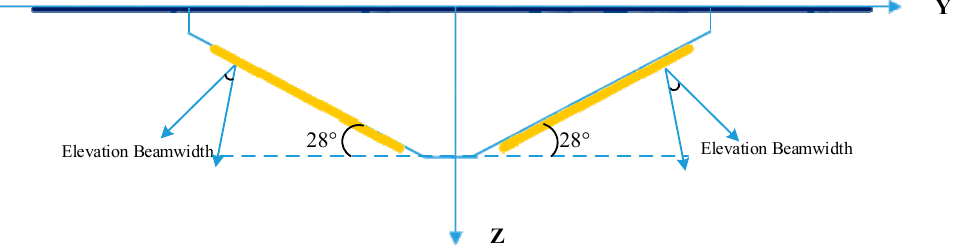
Figure 2. Schematic of spacecraft of one CYGNSS observatory and its two off-nadir LHCP antennae (yellow).